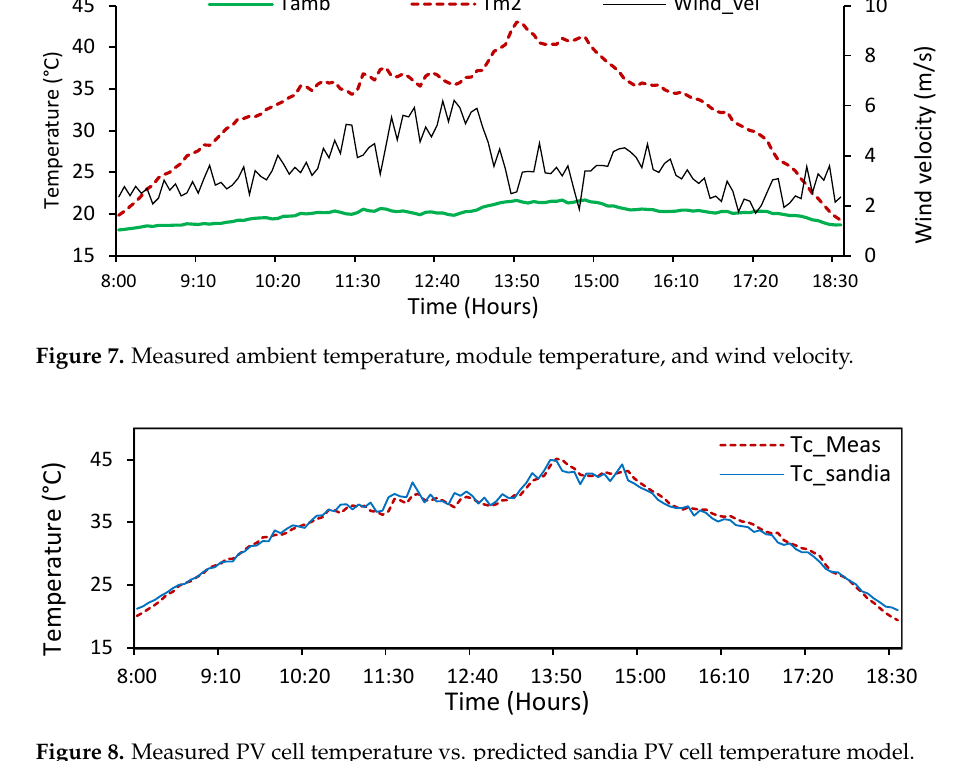
Figure 8. Measured PV cell temperature vs. predicted sandia PV cell temperature model. Table 7. Regression metrics for the used Sandia PV cell temperature model. Metrics/ MAE RMSE MAE (%) RMSE (%) R-Squared Values 0.61698 0.77446 1.3811 1.7336